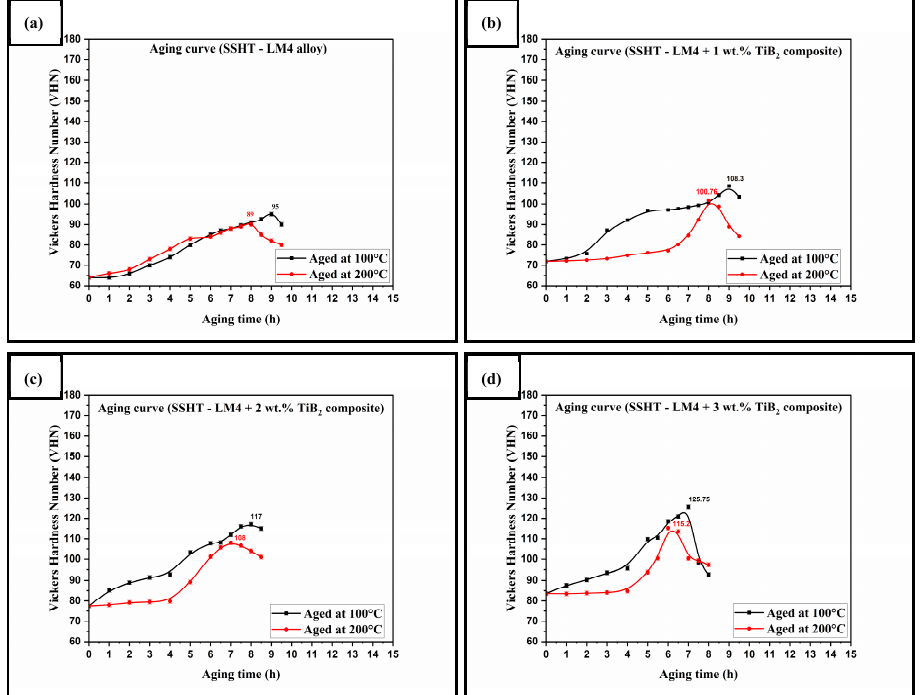
Figure 11. ( a – d ) Aging curves of the precipitation-hardened (SSHT + artificial aging) LM4 alloy and its composites.